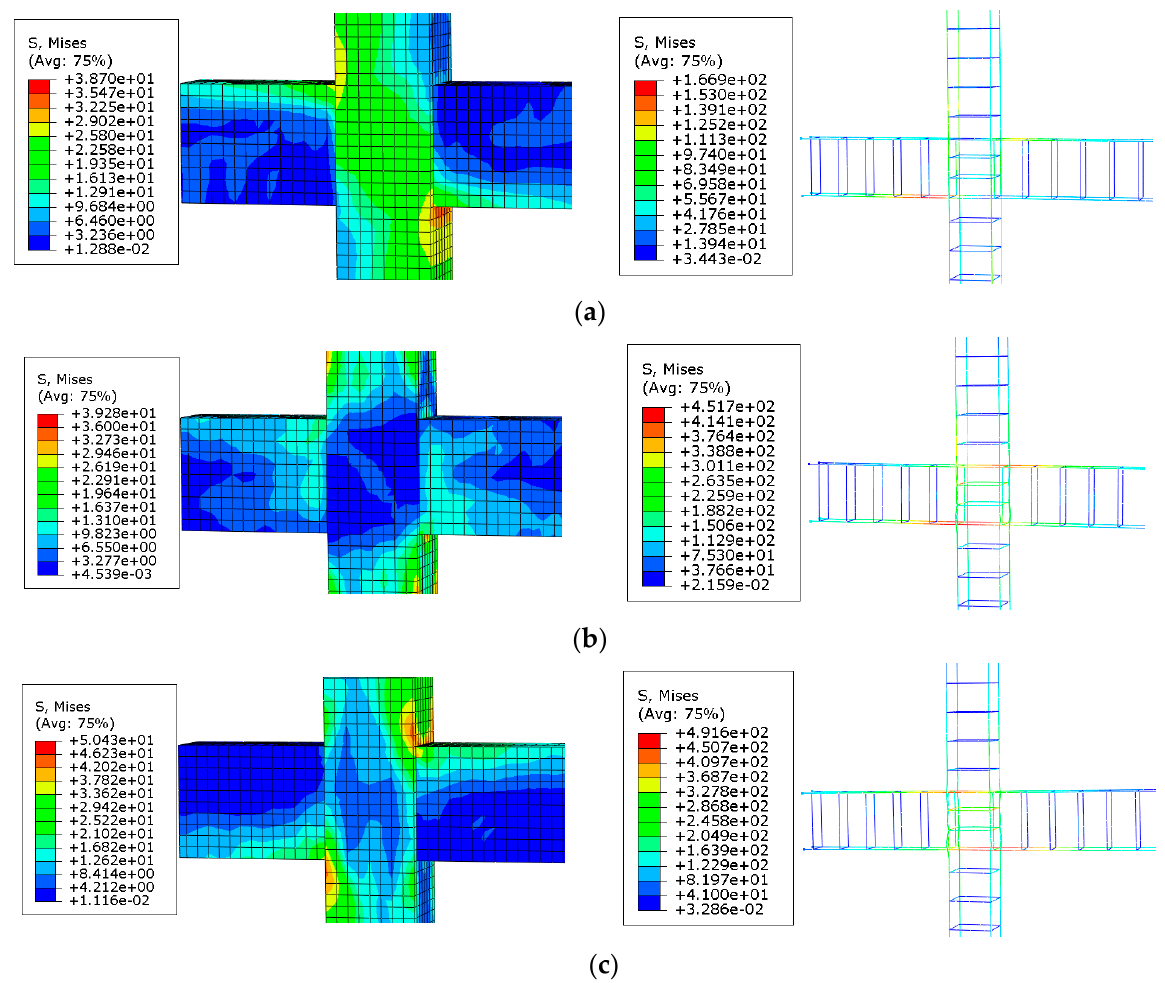
Figure 10. Stress distribution of reinforcement and concrete skeleton of BCJ1: ( a ) yield load; ( b ) peak load; ( c ) failure load.